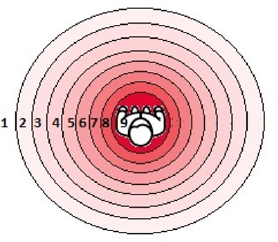
Figure 12. Test pattern for direction perception with a TactiBelt (calibration chart): the colored circles represent the space around the user. When moving the computer mouse on the circles, the vibrators are activated ; a vibrator characterizes the ego-orientation and ego-distance of the pointed 3D spot. Each circle corresponds to a precise amplitude of the vibration, from the greatest (level 9) to the lowest (level